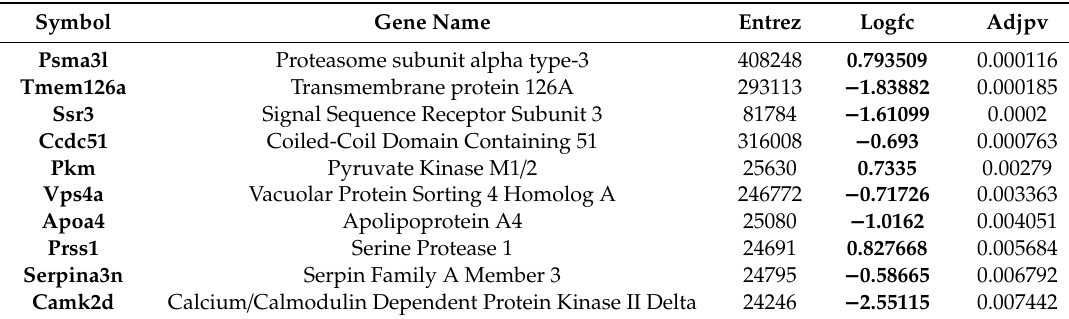
Table 1. Top 10 di ff erentially regulated proteins in BAT.